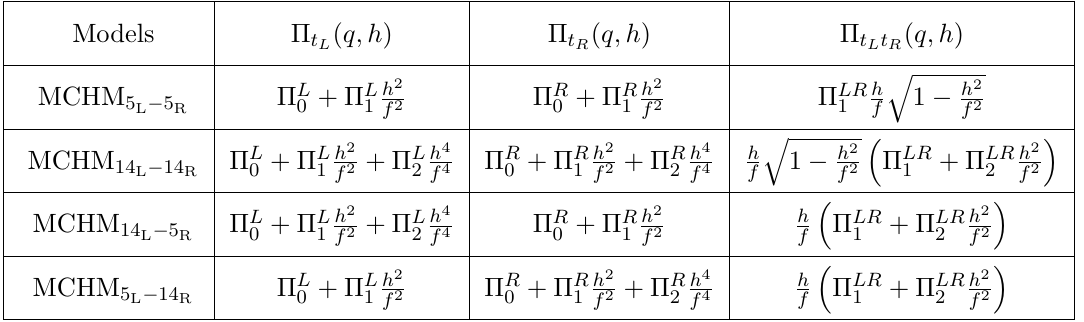
Table 1. List of (cid:5)-functions, de(cid:12)ned in eq. (2.2) for di(cid:11)erent